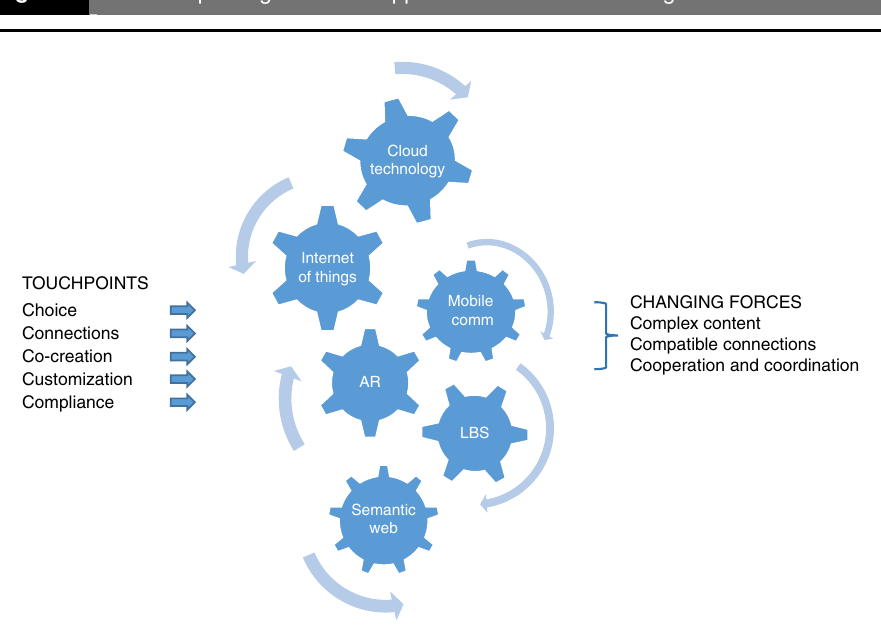
Figure 2 Predicted paradigm shifts in approaches to tourism